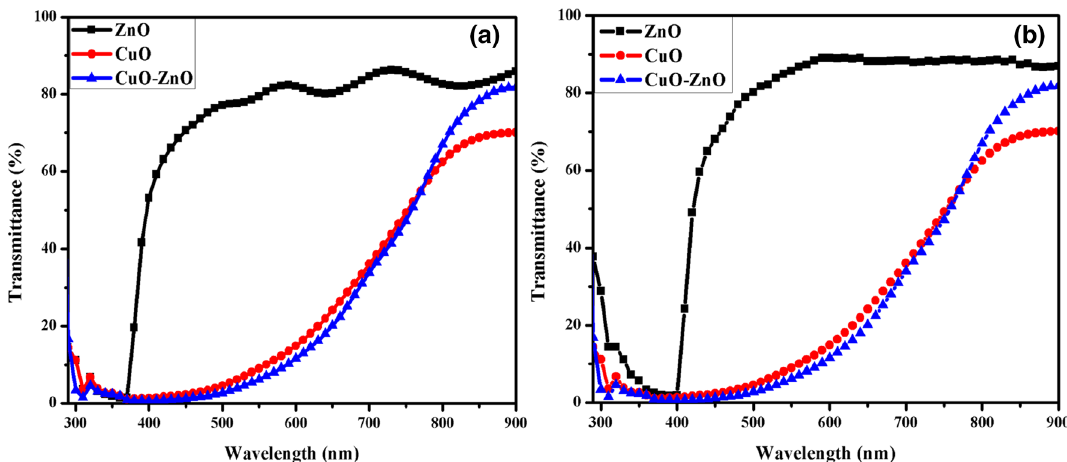
Fig. 4 Transmittance spectra of single and bilayer films at 400 °C ( a ) at 500 °C ( b )